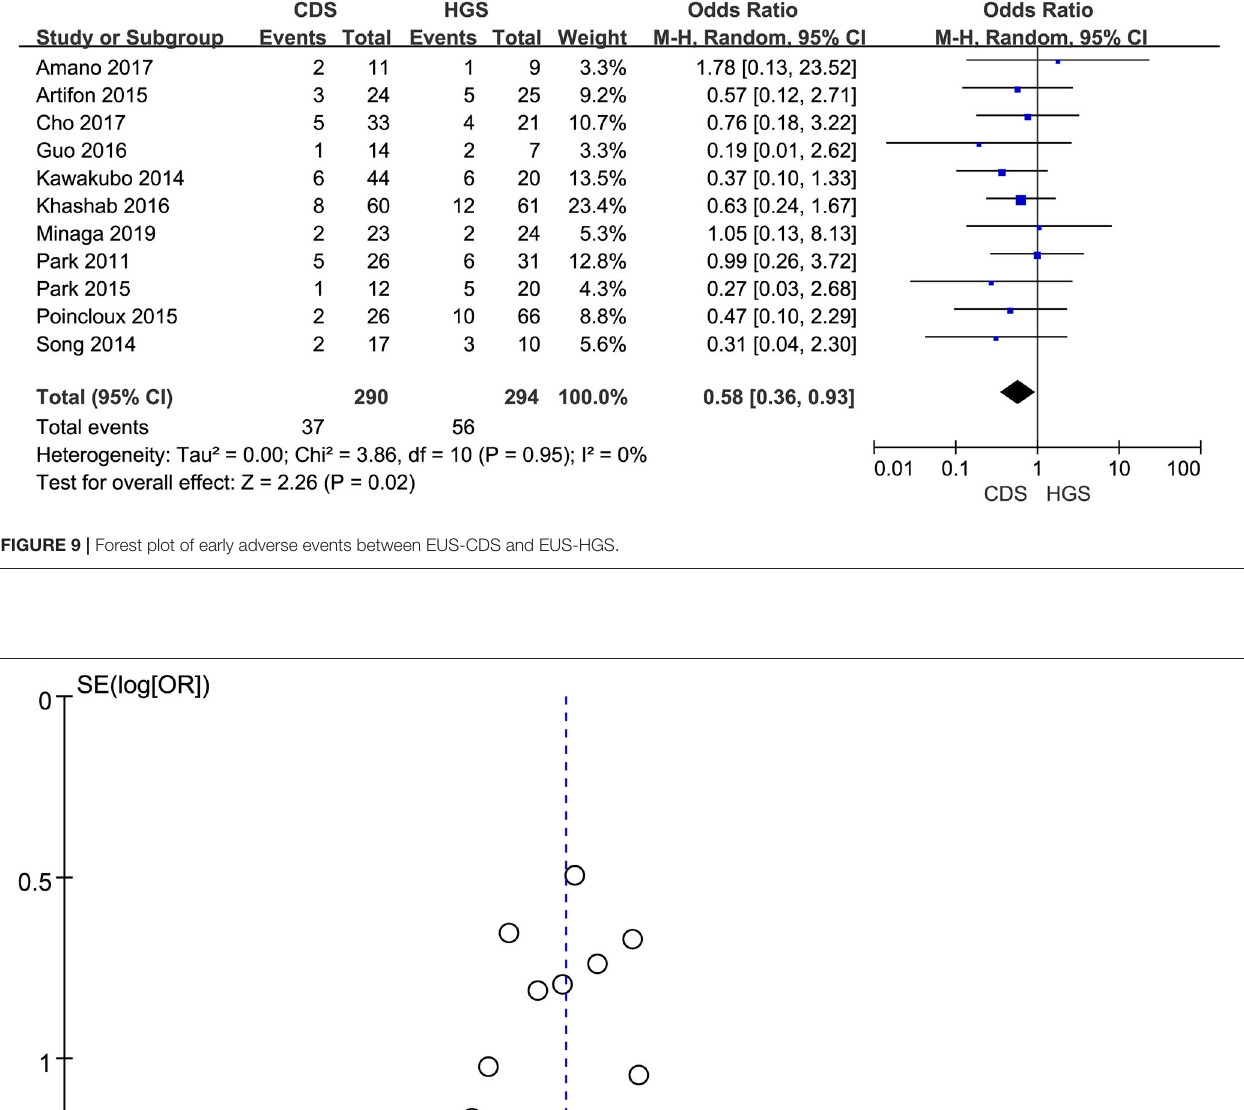
Frontiers in Surgery |